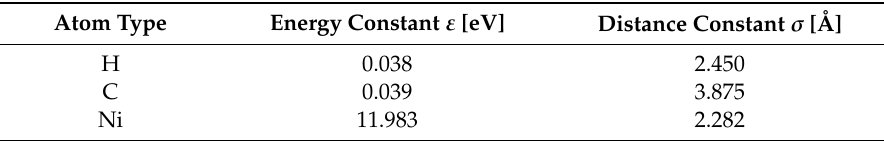
Table 1. Lennard–Jones (L-J) potential parameters for di ff erent atom types. Atom